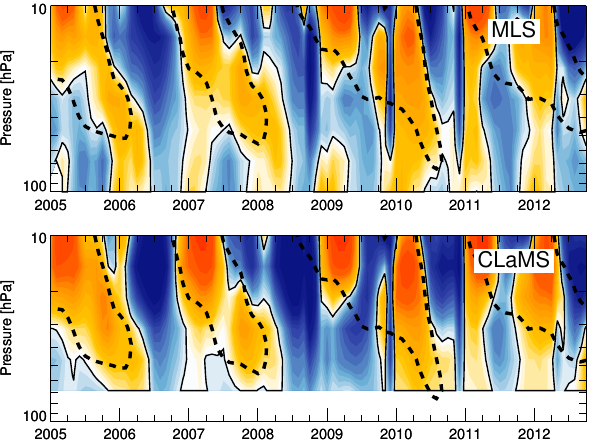
Figure 7. The anomaly pattern of tropical ( ± 15 ◦ ) N 2 O as observed by MLS (top panel) and as simulated by CLaMS (bottom panel) for the time period 1 January 2005 to 31 October 2012. In con- trast to Fig. 8 below, the CLaMS results are interpolated here on the MLS measurement locations and convoluted with the averag- ing kernels of MLS for a more accurate comparison. Dashed con- tours ( − 15ms − 1 wind line from ERA-Interim) illustrate the east- erly shear phase of the QBO.